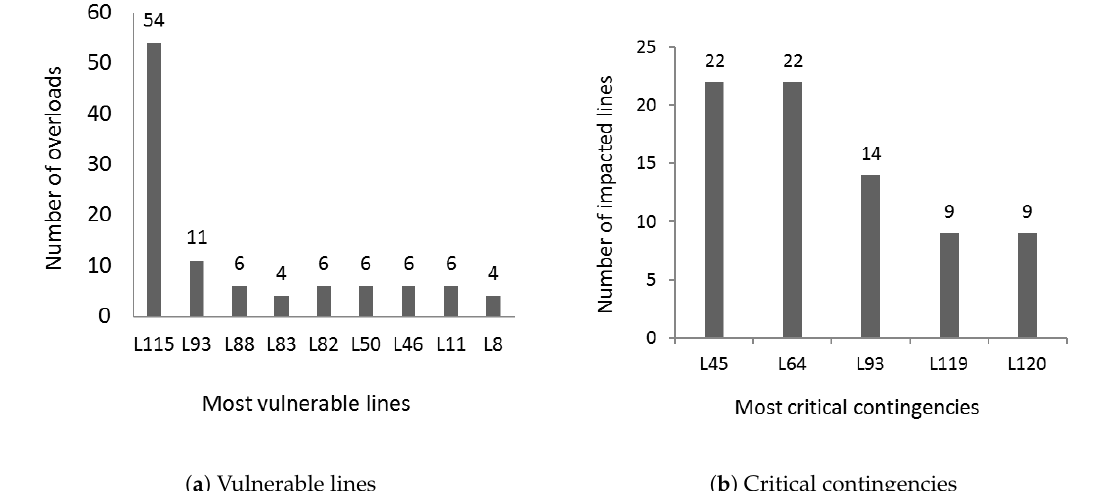
Figure 4. Vulnerable lines and critical contingencies considering TCF =